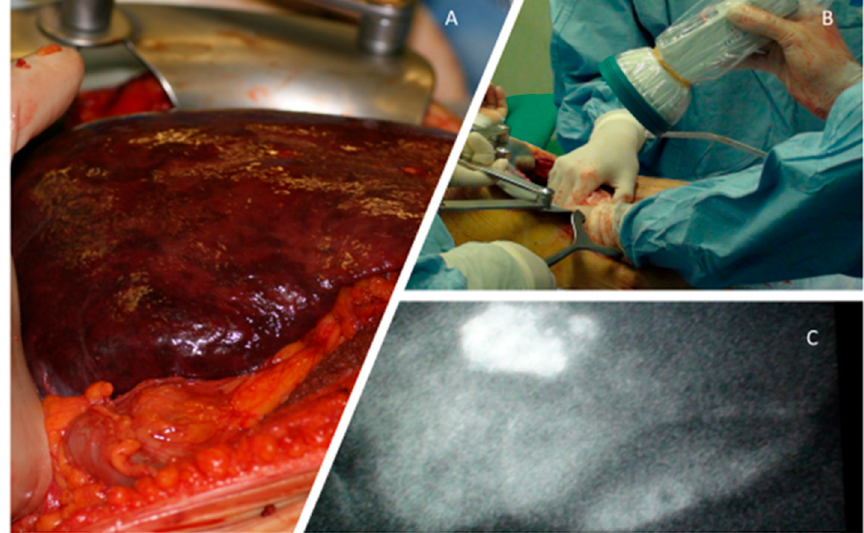
Figure 2. Cirrhotic liver ( A ). An intraoperative near-infrared fluorescence (NIR) examination ( B ) confirms an HCC ( C ).